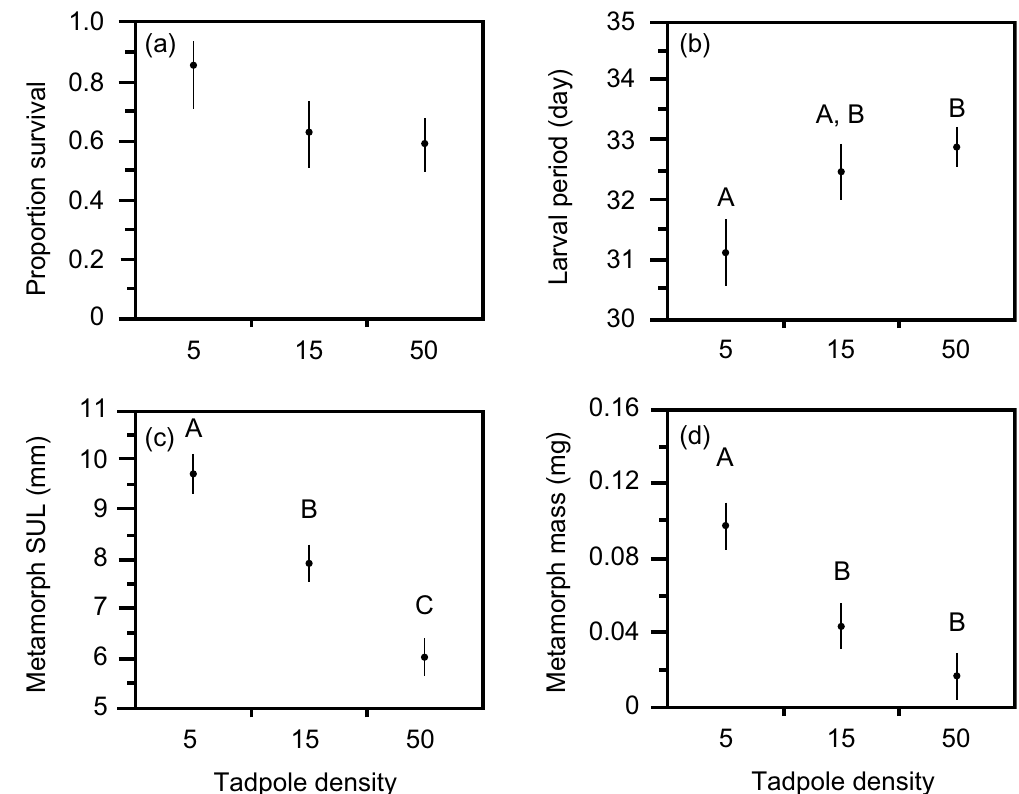
Figure 1. The effect of tadpole density on survival, larval period and metamorph size of toads, Bufo japonicus formosus . The treatments comprised densities of 5, 15 or 50 tadpoles per container. The panels show impacts on ( a ) survival rate, ( b ) larval period, ( c ) metamorph snout-urostyle length, and ( d ) metamorph mass. The graphs show mean values (based on 5 replicate containers per treatment) with standard errors. The same letter indicates that the differences are not significant using a post hoc test (Tukey’s HSD) at the 0.05